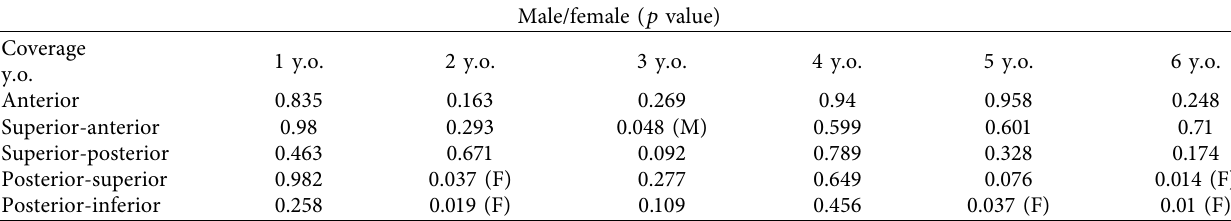
Table 3: Sex differences in FH coverage in children according to their age.